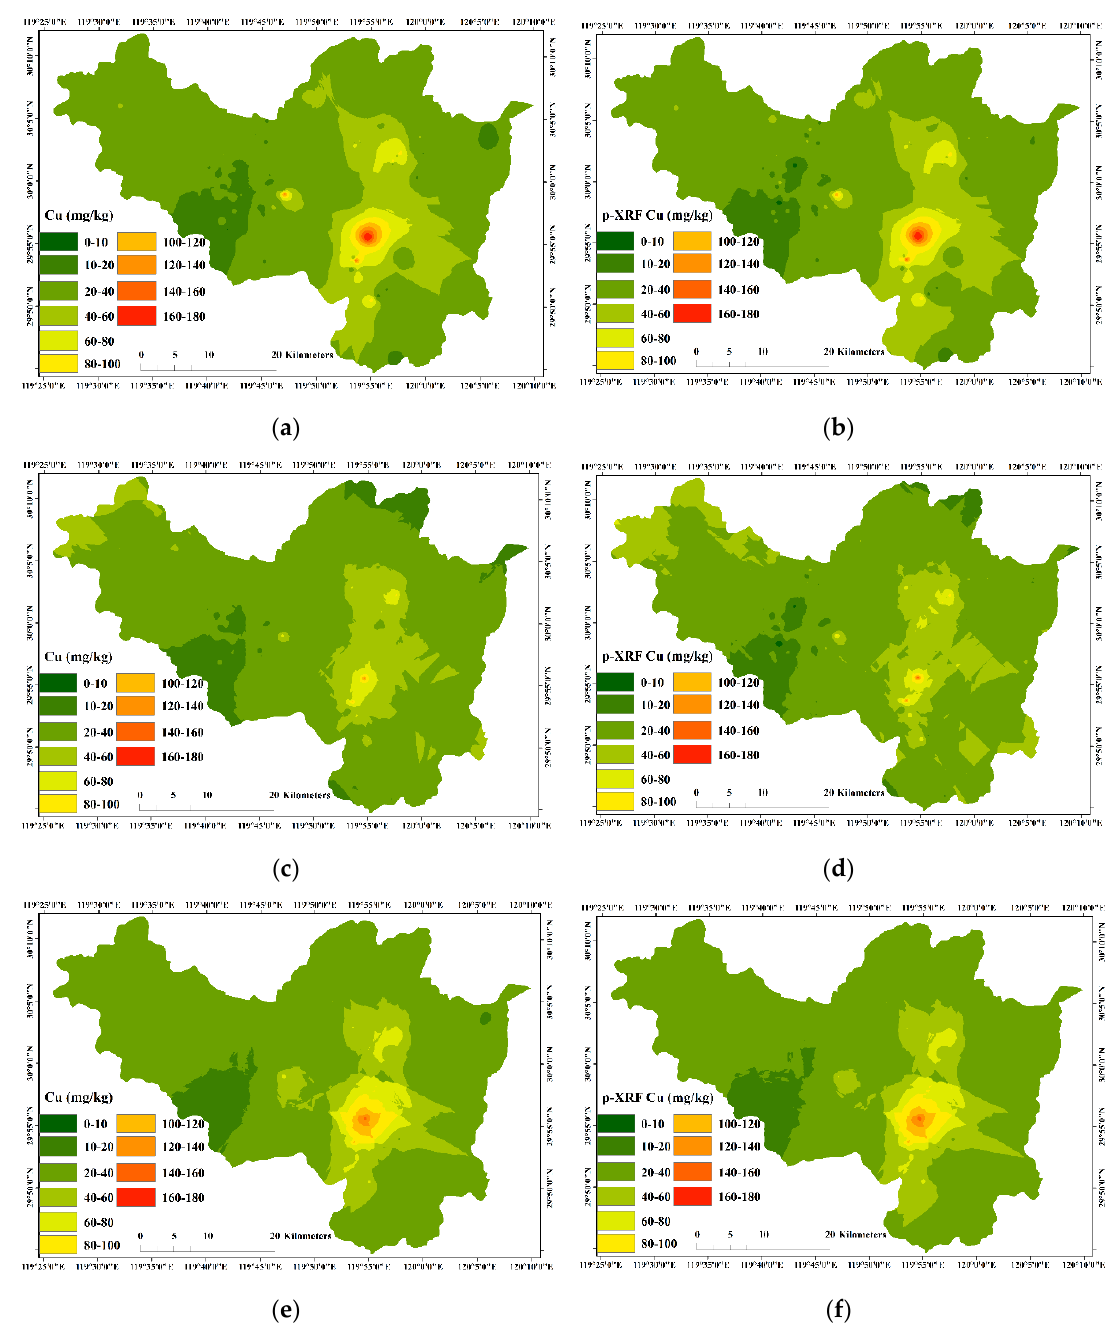
Figure 6. Maps of Cu content measured by LC-ICP-MS (left column) and p-XRF (right column) using IDW ( a , b ), OK ( c , d ), and EBK ( e , f ) geostatistical methods.